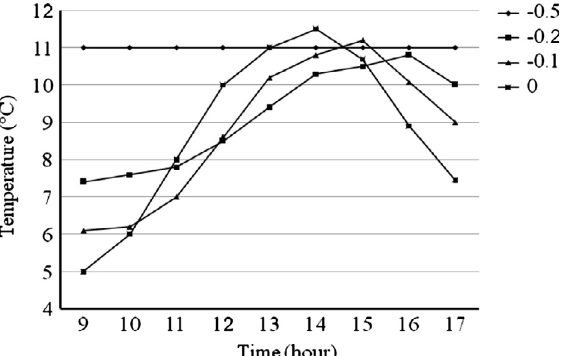
Figure 8. Horary evolution of the soil temperature (January 15).